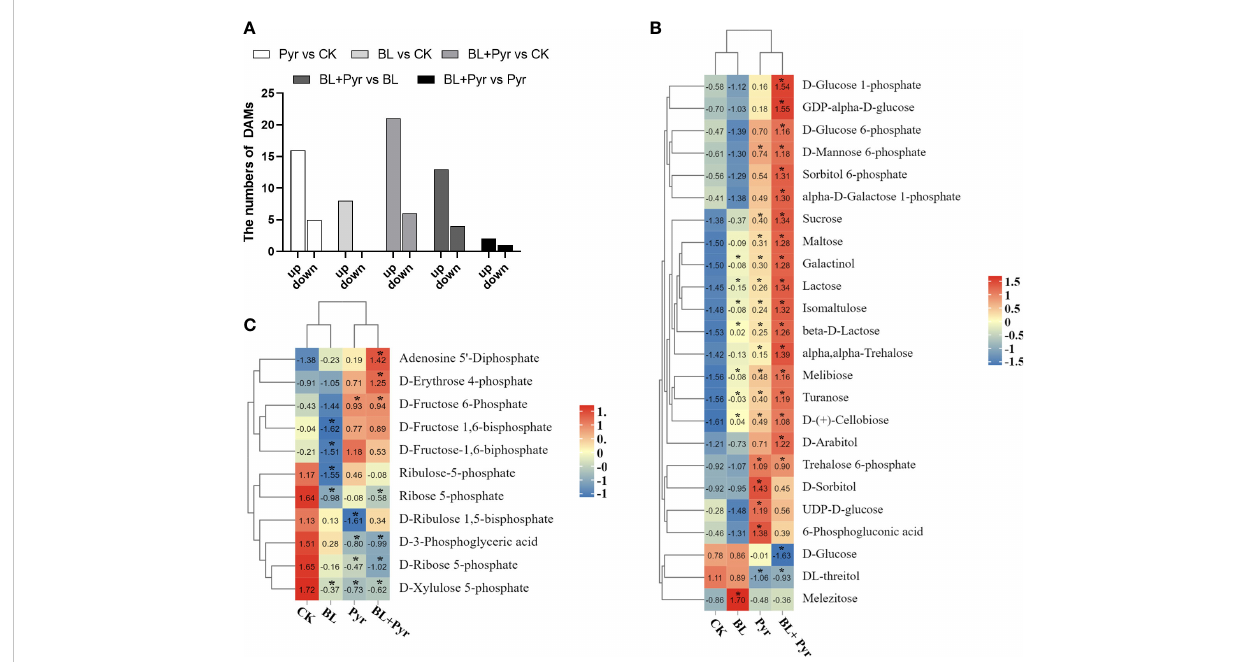
FIGURE 8 BL+Pyr showed a synergistic effect on increasing the accumulation of photosynthates. (A) Number of DAMs in the CO 2 fi xation pathway and belonging to sugars of the three treatments (BL + Pyr, BL and Pyr) versus the untreated group; (B) Hierarchical cluster analysis of the sugars content of the three treatments (BL + Pyr, BL and Pyr) versus the untreated group; (C) Hierarchical cluster analysis of the content of DAMs in the CO 2 fi xation pathway of the three treatments (BL + Pyr, BL and Pyr) versus the untreated group. The Metabolites with variable importance in projection (VIP) ≥ 1, fold change (FC) ≤ 0.8 or ≥ 1.2, and P-value< 0.05 were classi fi ed as DAMs (differential accumulation metabolites). Values shown in (B, C) are Z-scores normalized to concentrations, and ‘ * ’ represent signi fi cant differences versus the untreated